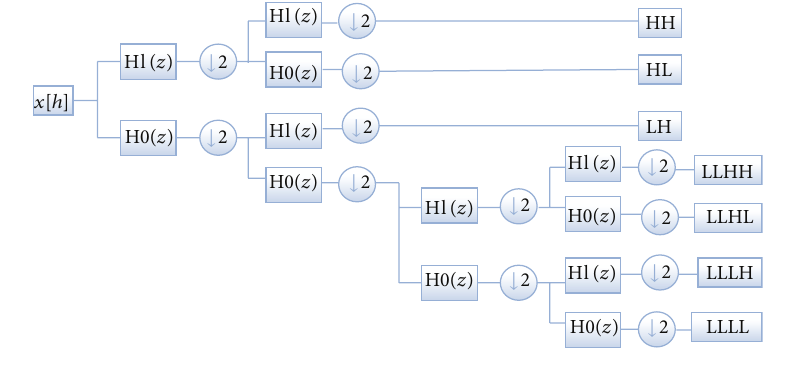
Figure 2: Standard DWT [13].